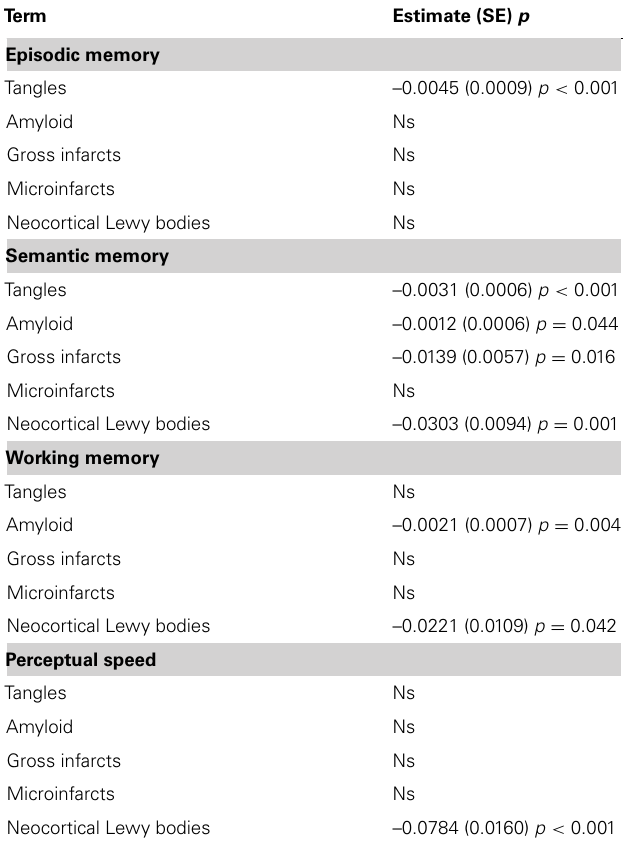
Table 2 | Relation of the neuropathologies with rate of decline in four cognitive